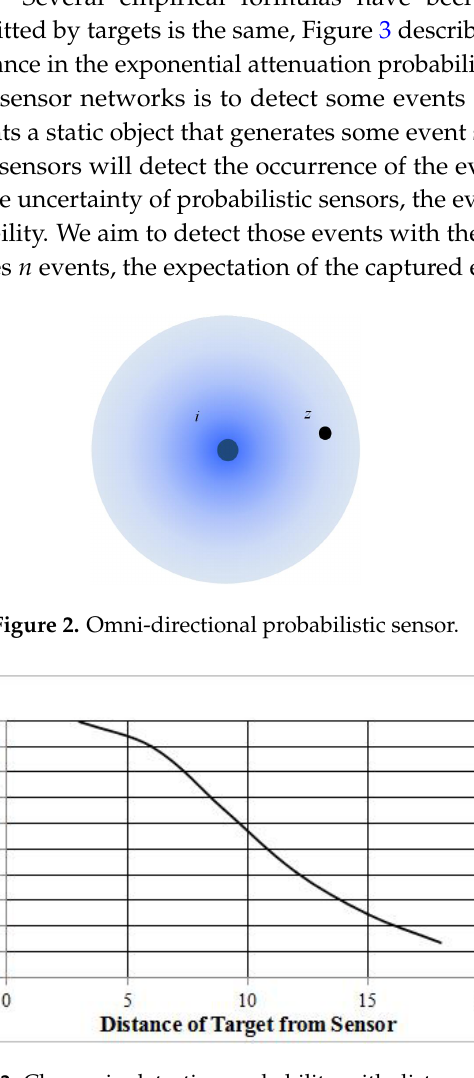
Figure 3. Change in detection probability with distance